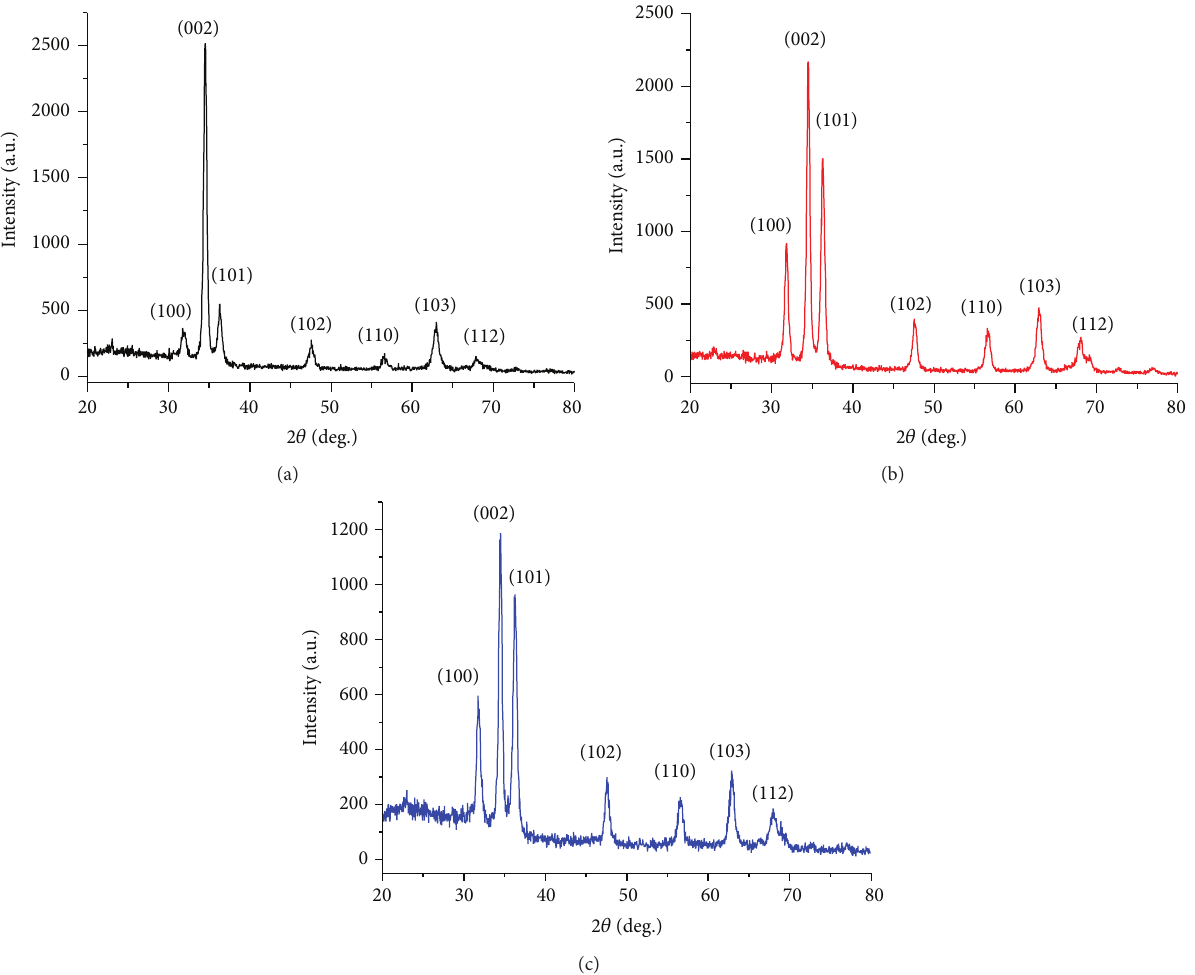
Figure 1: XRD pattern of undoped and Cu doped ZnO thin films sample. Here (a), (b), and (c) correspond to samples Z1, Z1C1, and Z1C2, respectively, prepared using precursor solution of molarity of 0.1